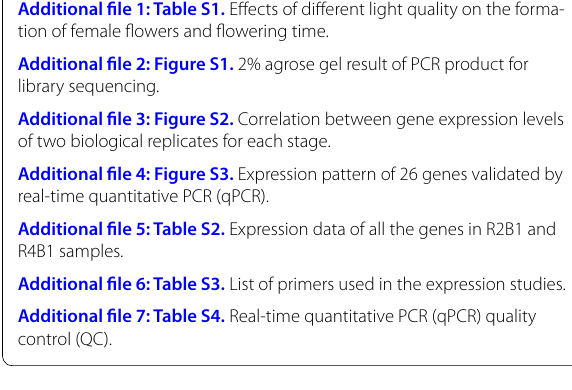
Additional file 2: Figure S1. 2% agrose gel result of PCR product for library sequencing. Additional file 3: Figure S2. Correlation between gene expression levels of two biological replicates for each stage. Additional file 4: Figure S3. Expression pattern of 26 genes validated by real-time quantitative PCR (qPCR). Additional file 5: Table S2. Expression data of all the genes in R2B1 and R4B1 samples. Additional file 6: Table S3. List of primers used in the expression